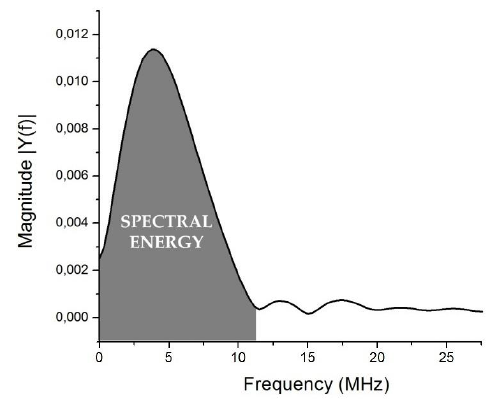
Figure 10. Spectrum of the MW, with schematic definitions of spectral energy E s .